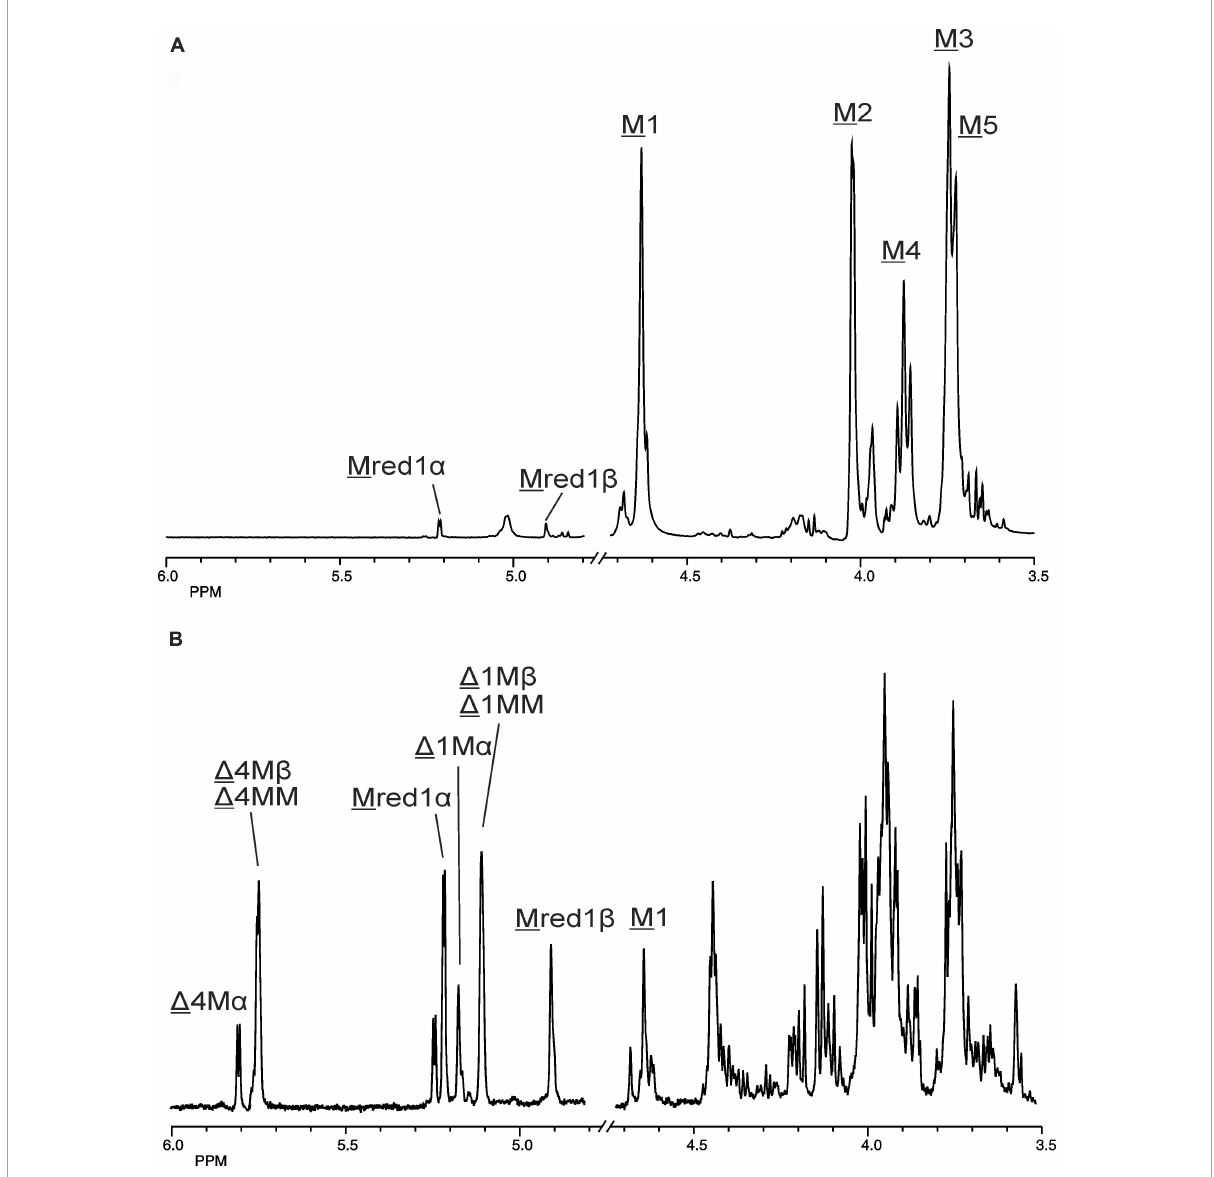
FIGURE4 1D 500-MHz 1 H NMR spectra (300K, D 2 O) of (A) the M-block alginate substrate before addition of the AlyRm3 enzyme, and (B) the oligosaccharide mixture generated after a 24-h incubation of the M-block alginate substrate with AlyRm3. M1 to M5 mean H-1 to H-5